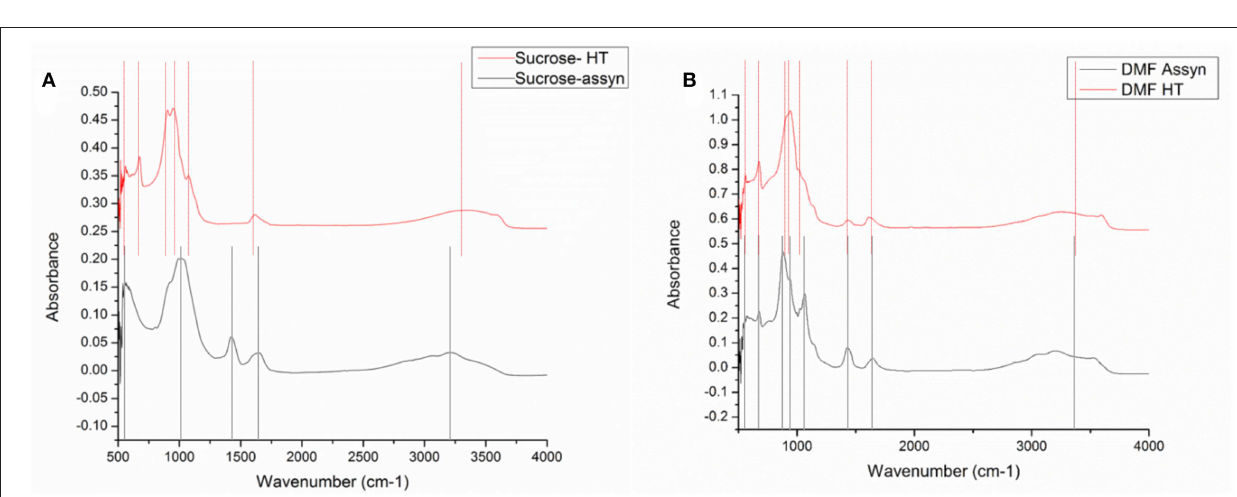
FIGURE 3 | FTIR images for (A) as-synthesized and calcined VOPO4 samples synthesized with DMF based precursor (B) as- synthesized and calcined VOPO4 samples synthesized with sucrose-based